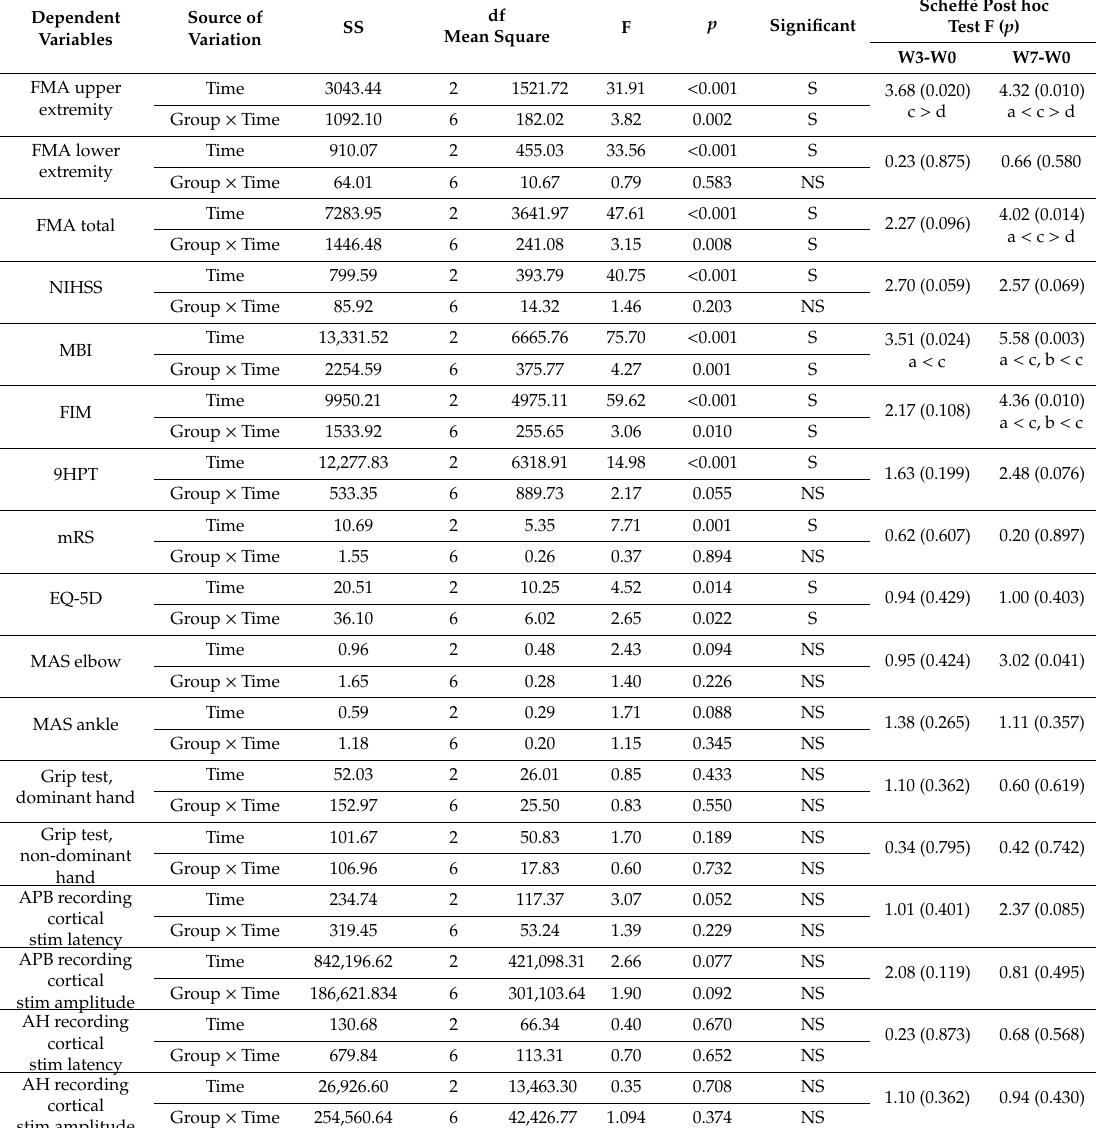
Table 4. Results of repeated-measures ANOVA and Sche ff é post hoc test for the outcomes of treatment. Dependent